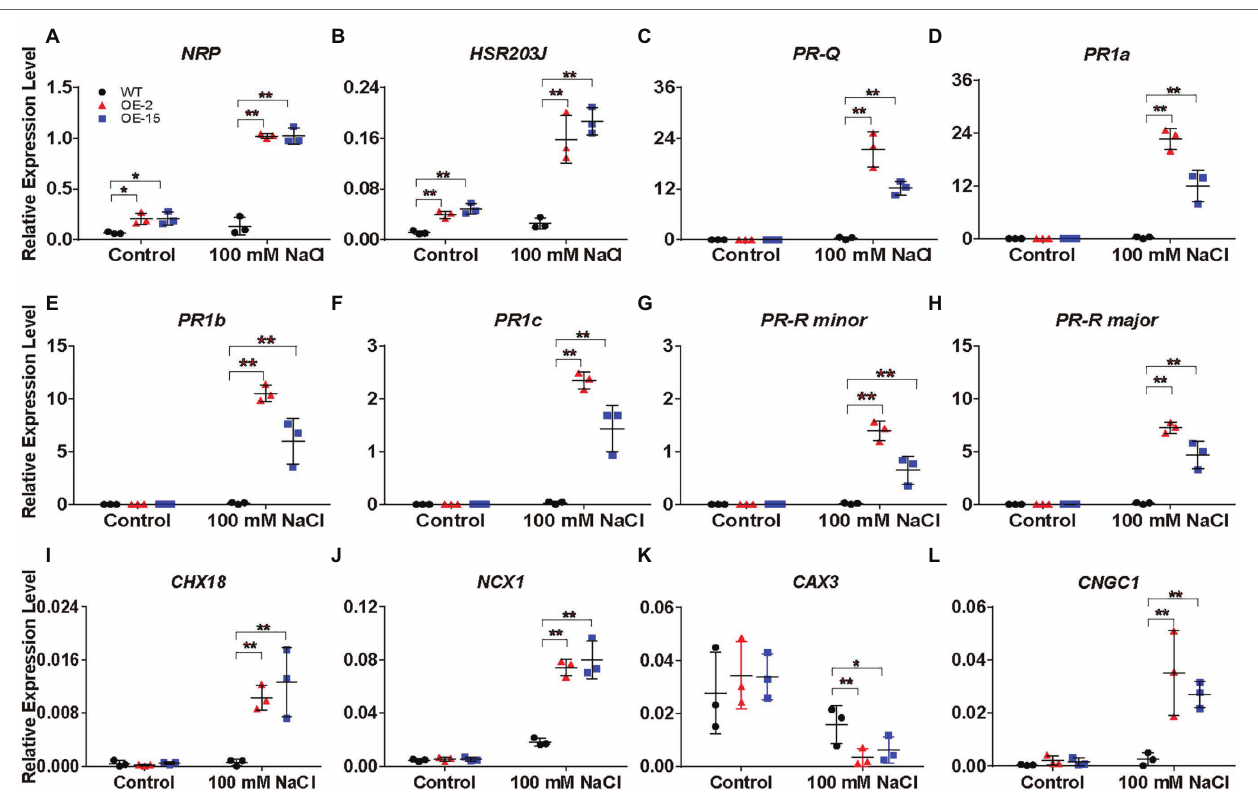
FIGURE 9 | Relative expression analysis of plant defense-related marker genes, Na + homeostasis- and Ca 2+ homeostasis-related genes determined by RT-qPCR in tobacco leaves. (A-L) The expression of these genes is relative to the reference gene L25 under control conditions and salt stress (100 mM NaCl) at 4 days after the start of treatment. Their gene IDs in the reference tobacco genome database (ftp://ftp.solgenomics.net/genomes/Nicotiana_tabacum/edwards_et_al_2017/ assembly/Nitab-v4.5_genome_Chr_Edwards2017.fasta.gz) are N-RICH PROTEIN ( NRP ; Nitab4.5_0000798g0120), HSR203J (Nitab4.5_0002719g0120), PR-Q (Nitab4.5_0003207g0080), PR1a (Nitab4.5_0003771g0010), PR1b (Nitab4.5_0005400g0020), PR1c (Nitab4.5_0004861g0040), PR-R minor (Nitab4.5_0004097g0050), PR-R major (Nitab4.5_0000360g0100), Cation/H + EXCHANGER 18 ( CHX18 ; Nitab4.5_0006998g0030), Na + /Ca 2+ EXCHANGER 1 ( NCX1 ; Nitab4.5_0005404g0030), CATION/PROTON 3 ( CAX3 ; Nitab4.5_0000102g0080), and CNGC1 (Nitab4.5_0000258g0120). Error bars indicate ±SD ( n = 3). One-way ANOVA with LSD test (* p < 0.05 and ** p < 0.01) was used to analyze statistical